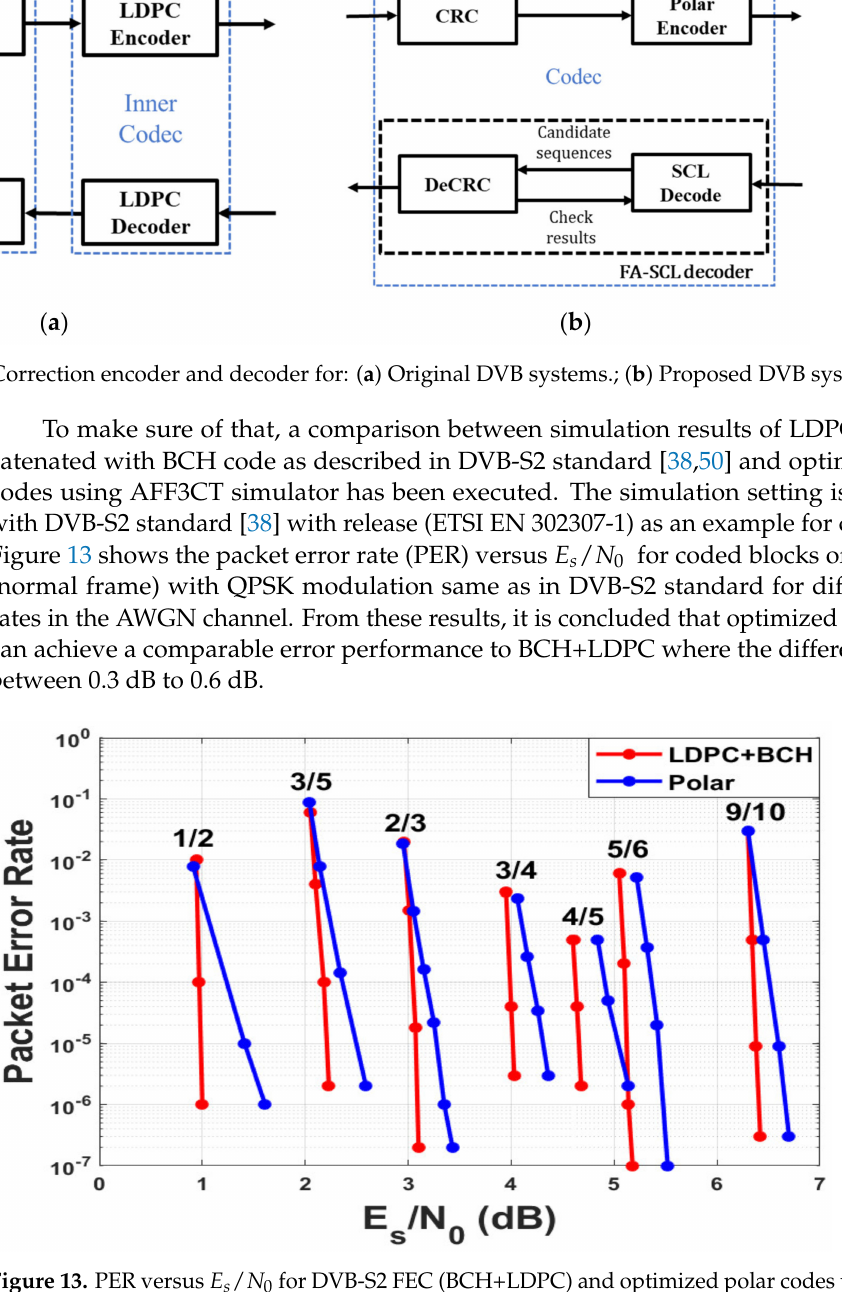
Figure 13. PER versus E s / N 0 for DVB-S2 FEC (BCH+LDPC) and optimized polar codes using normal frame and different code